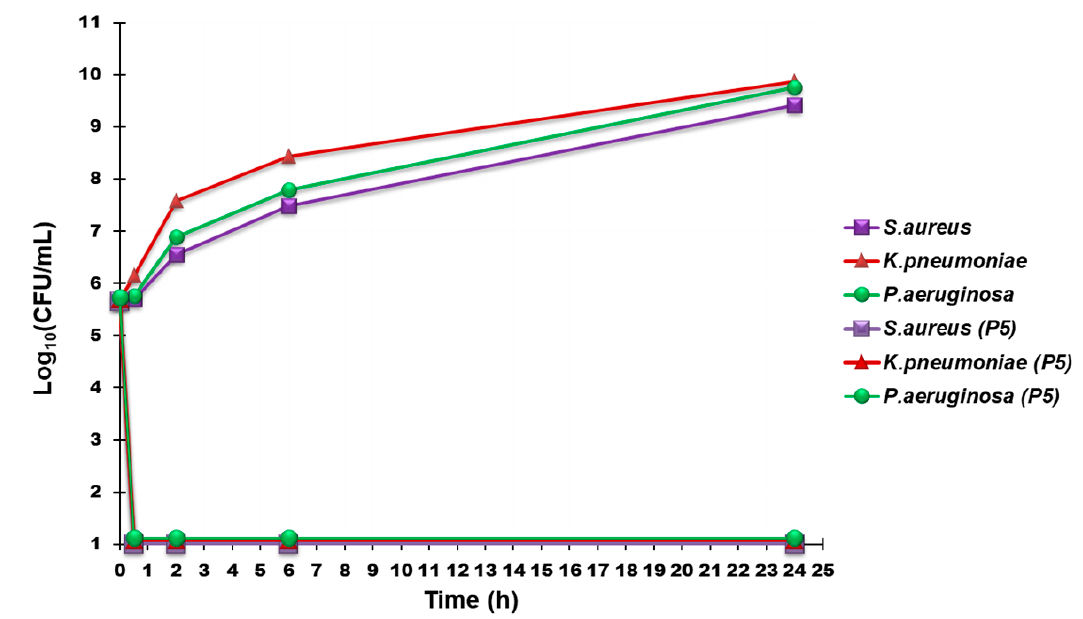
Figure 4. Time-killing curves performed with P5 (at concentrations equal to 4 × MIC) on P. aeruginosa 247, K. pneumoniae 366 and S. aureus 18.